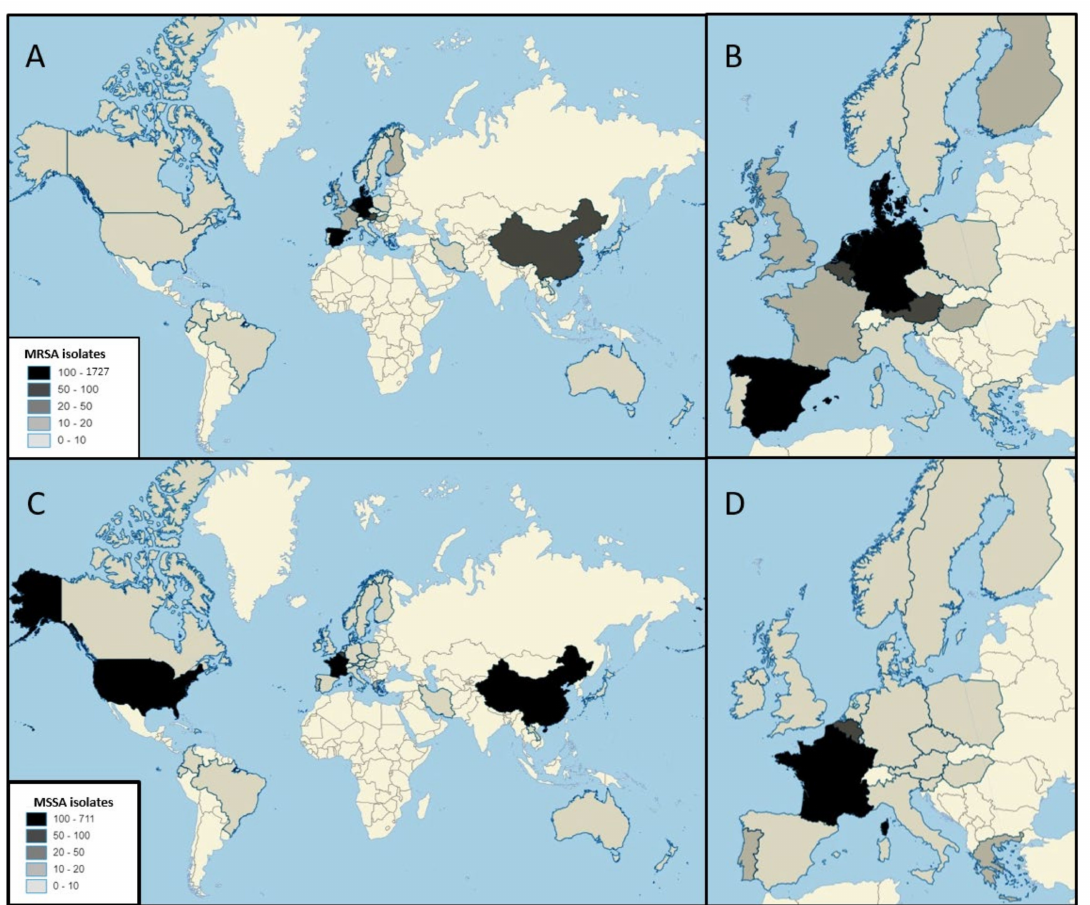
Figure 2. Number of MRSA ( A , B ) and MSSA ( C , D ) CC398 isolates from clinical infection in the world and in Europe. MRSA: Denmark ( n = 1727), Germany ( n = 600), The Netherlands ( n = 446), Spain ( n = 310), China ( n = 78), Belgium ( n = 77), Austria ( n = 67), Sweden ( n = 2), Slovenia ( n = 6), France ( n = 18), Luxembourg ( n = 16), United Kingdom ( n = 14), Hungary ( n = 12), Finland ( n = 10), New Zealand ( n = 7), Italy ( n = 6), Greece ( n = 4), Canada ( n = 4), United States ( n = 3), Japan ( n = 2), Hong Kong ( n = 2) Laos ( n = 1), Japan ( n = 1), Australia ( n = 1) , Norway ( n = 1), Ireland ( n = 1), Poland ( n = 1); MSSA: France ( n = 711), China ( n = 255), United States ( n = 117), Belgium ( n = 58), Portugal ( n = 18), Greece ( n = 17), The Netherlands ( n = 7), Dominican Republic ( n = 7), Iran ( n = 6), Germany ( n = 6), Spain ( n = 4), Denmark ( n = 4), Laos ( n = 4), Ireland ( n = 2), Colombia ( n = 2), Italy ( n = 1), Ecuador ( n = 1), Brazil ( n =